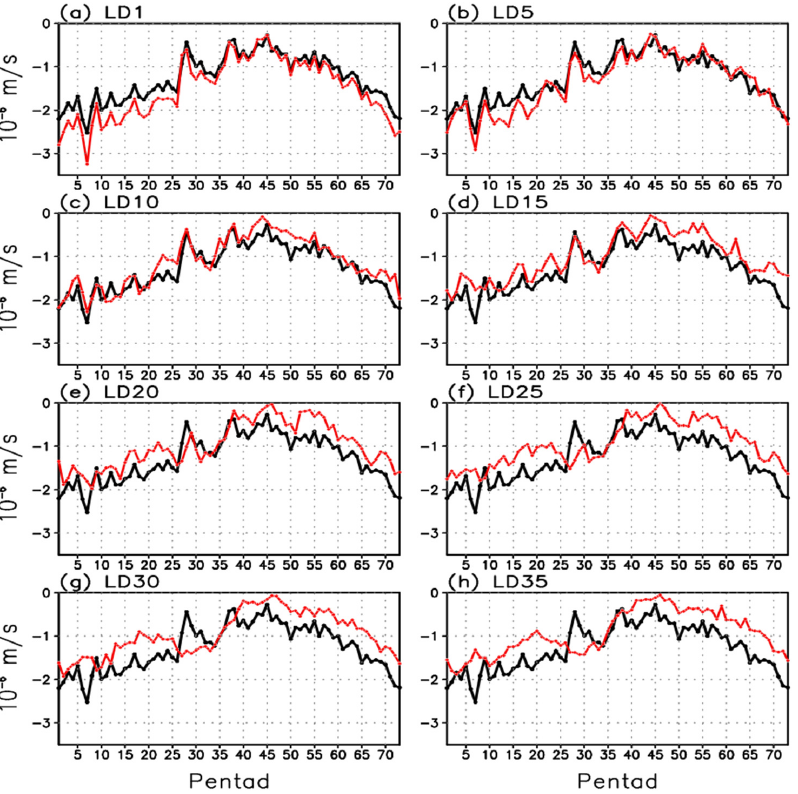
Figure 10. Same as in Figure 9, but for ∇⋅ Vh (10 − 6/s)). ( a ) LD1; ( b ) LD5; ( c ) LD10; ( d ) LD15; ( e ) LD20; ( f ) LD25; ( g ) LD30; and ( h ) LD35.